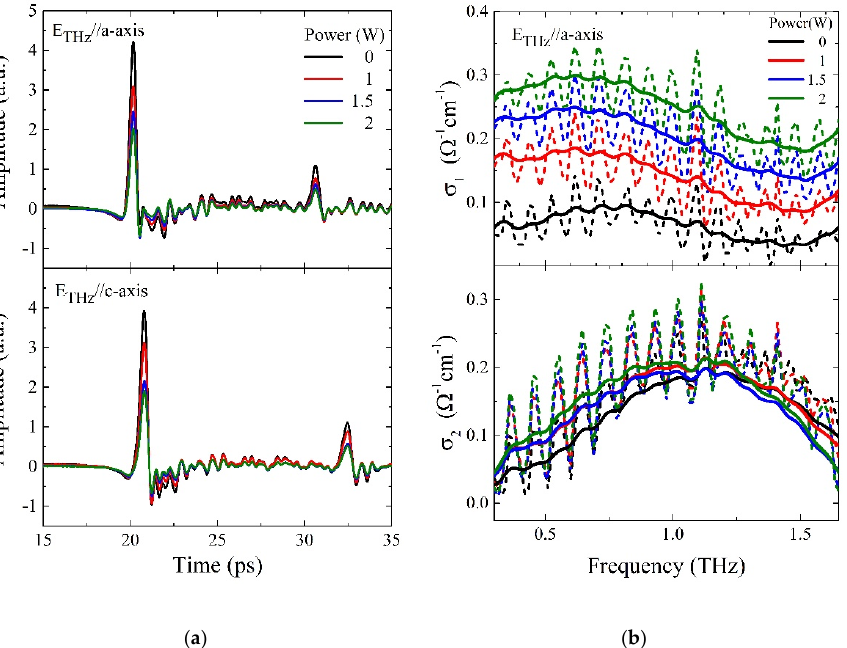
Figure 3. ( a ) Waveforms of the THz pulses transmitted through the excited Fe-doped (010) β -Ga 2 O 3 along E THz //a-axis and E THz //c-axis at 800 nm with various illumination powers. ( b ) Calculated complex conductivity. The solid lines are obtained by using the first peak pulse only, and the dashed ones using the first and second pulses.